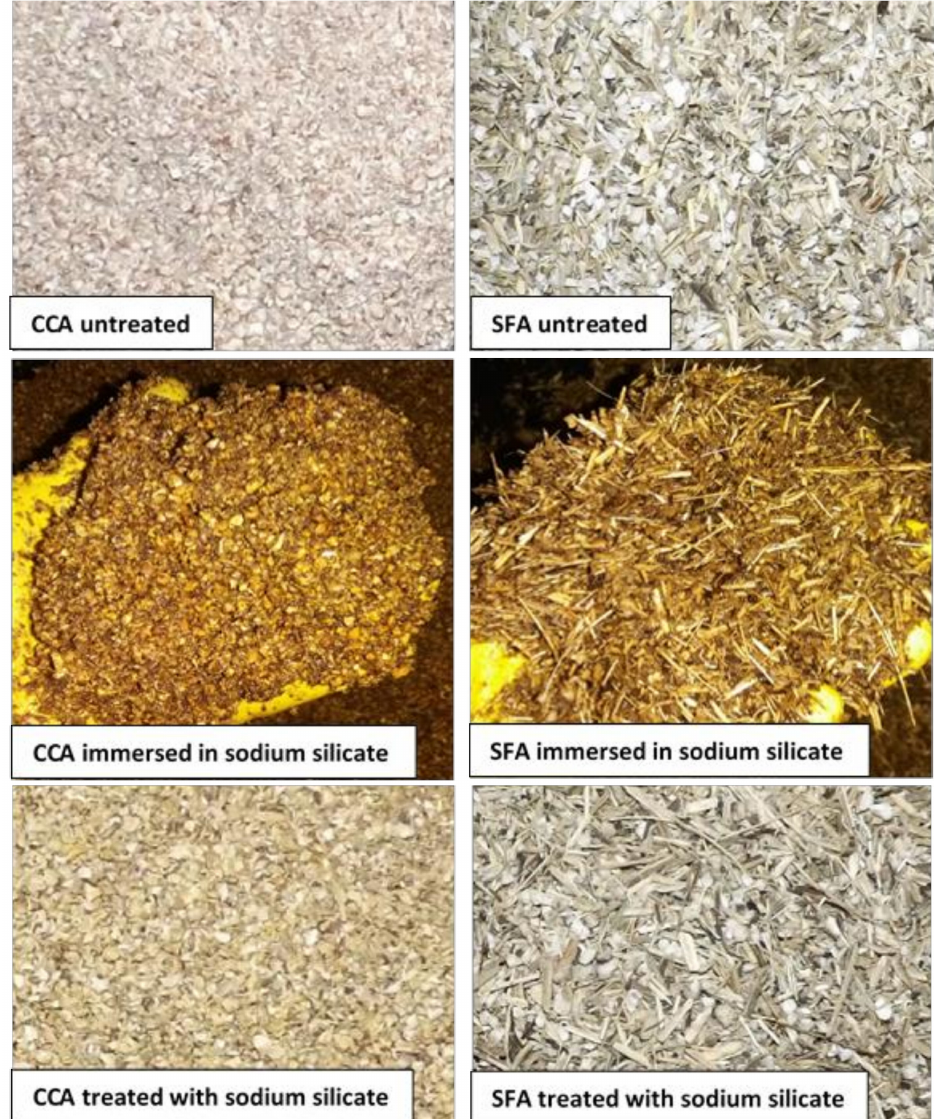
Figure 1. The corn cobs aggregates (CCA) and sunflower aggregates (SFA)